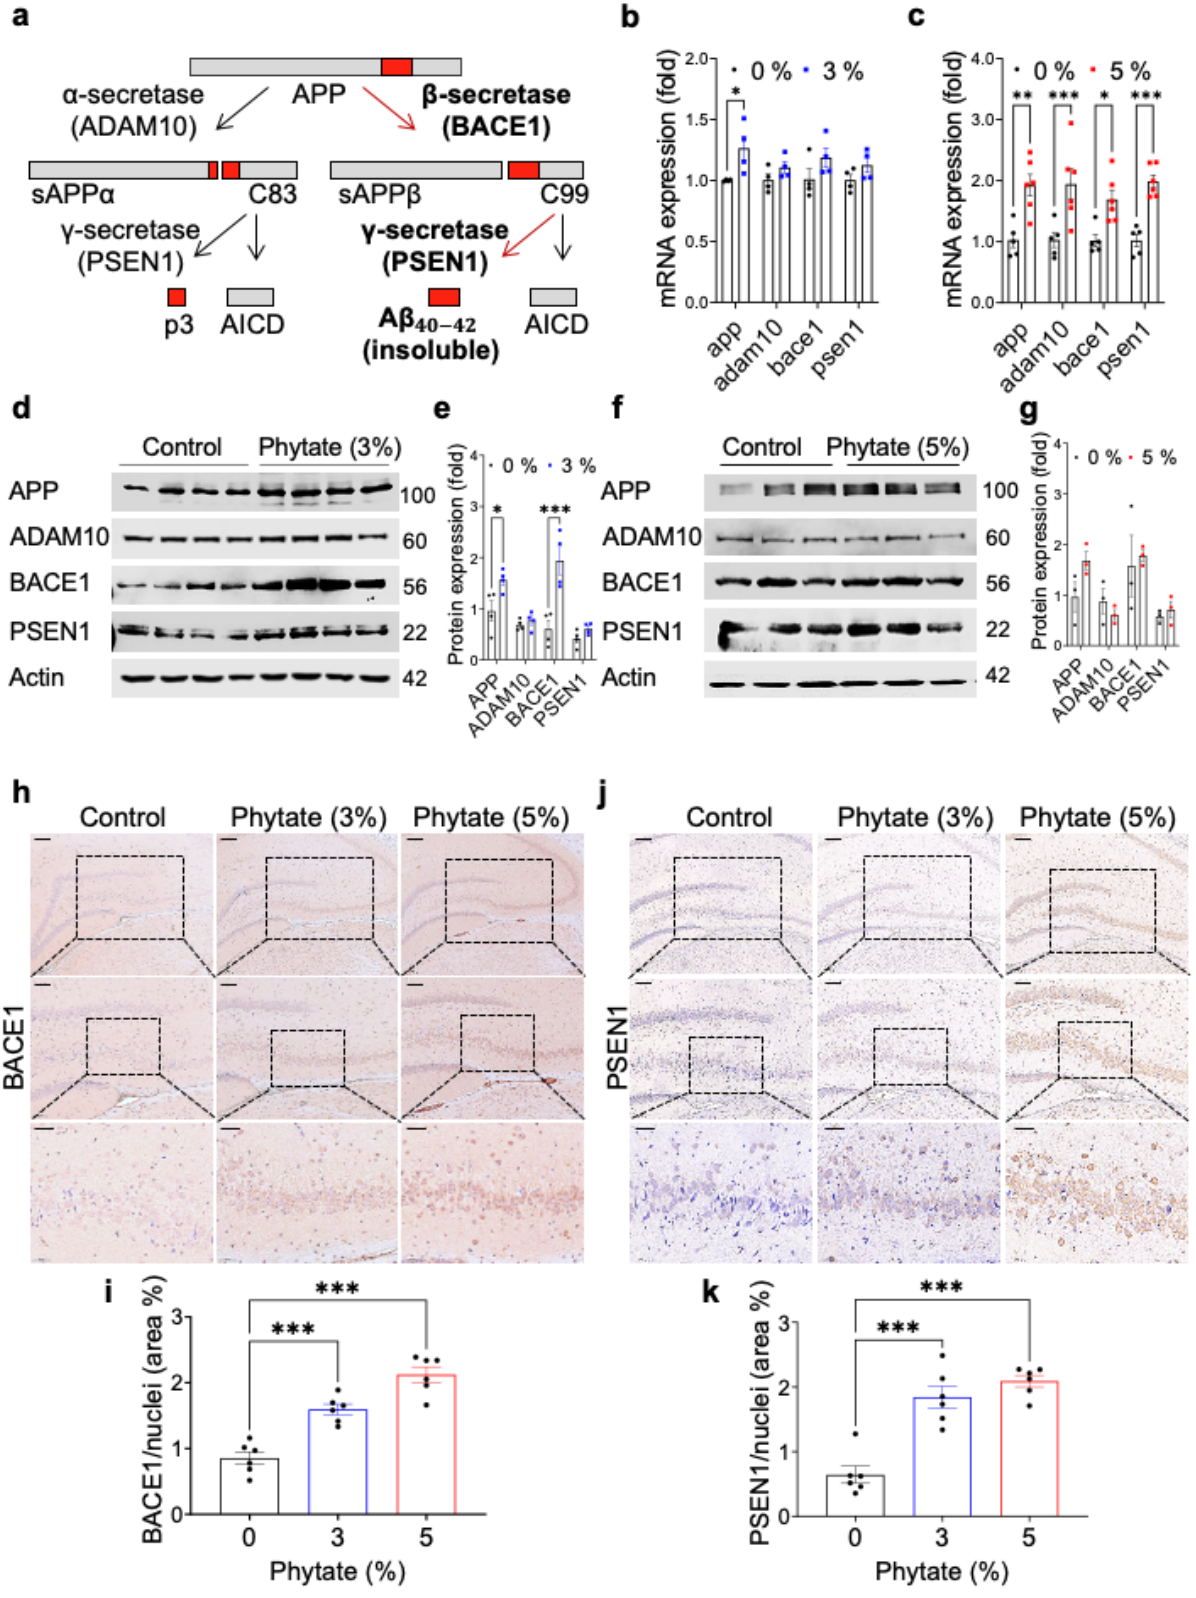
Figure 2. Rats fed high-phytate diets show elevated expression of APP and the BACE1 and PSEN1 amyloidogenic enzymes and increased A β accumulation in the hippocampus: ( a ) Schematic diagram of either amyloidogenic or